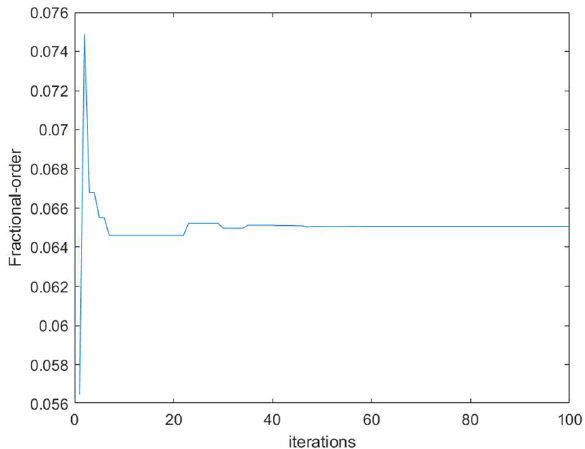
Figure 2. Fractional-order convergence process of model 1. The 0.065 order cumulative sequence is as follows.